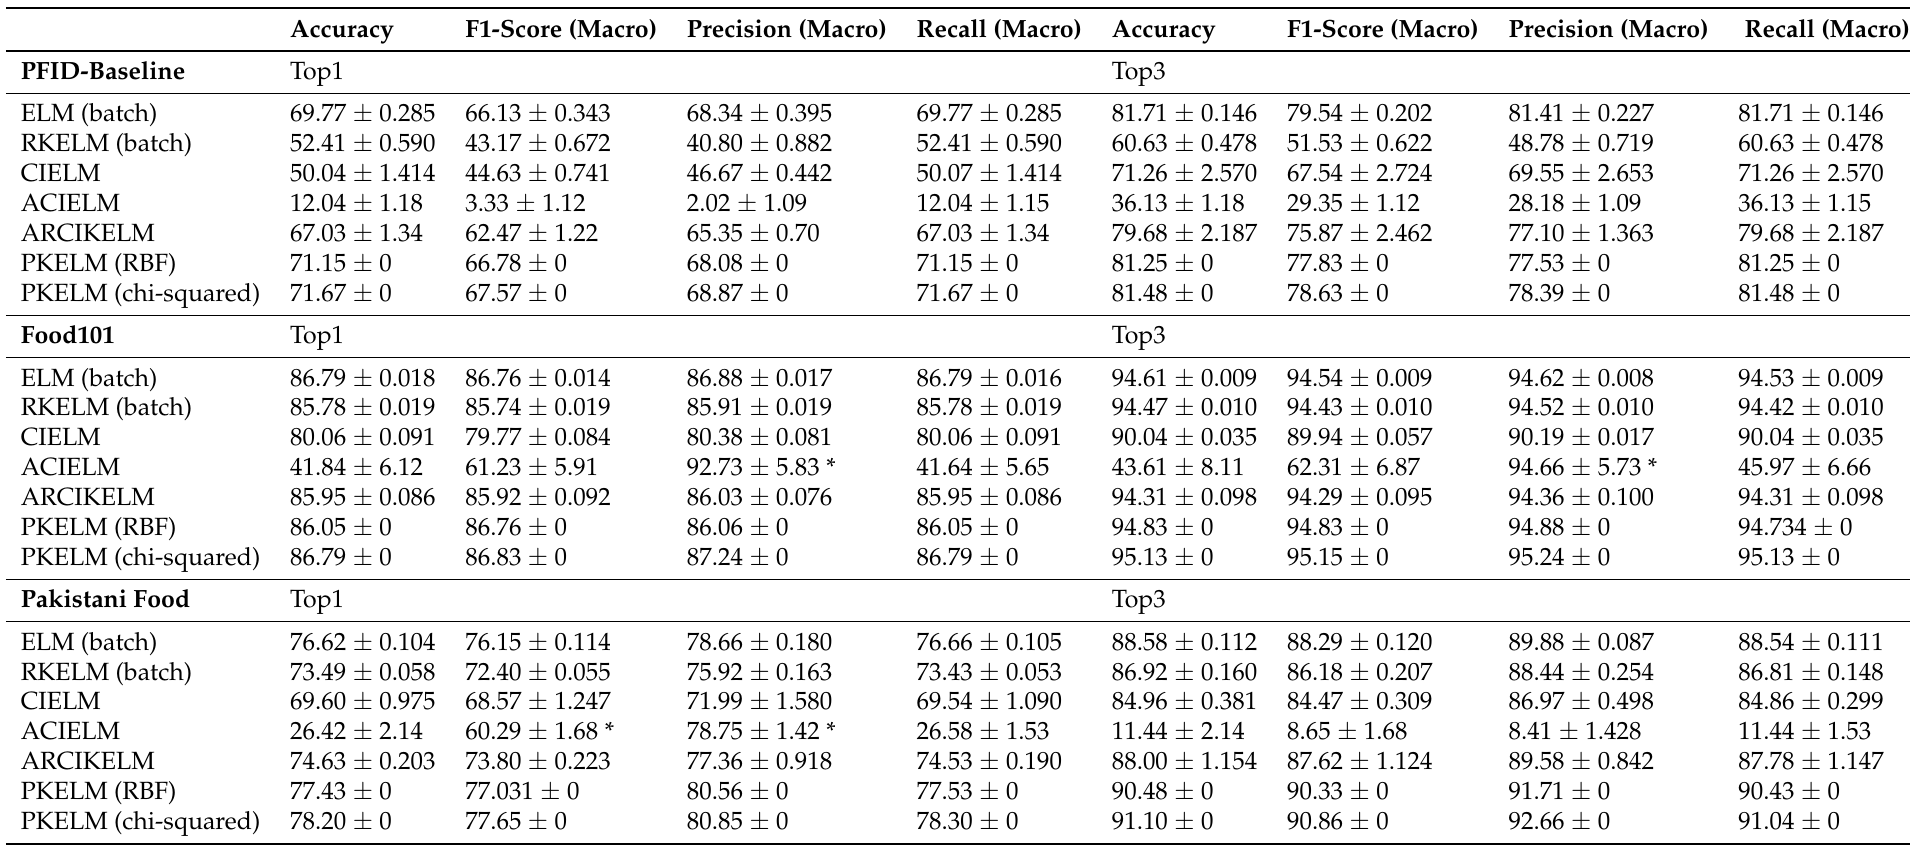
Table 5. Comparison of classification accuracy averaged over all sessions of the learning. If the precision and recall values in the session are not defined. Those values are denoted by 1 and are replaced by